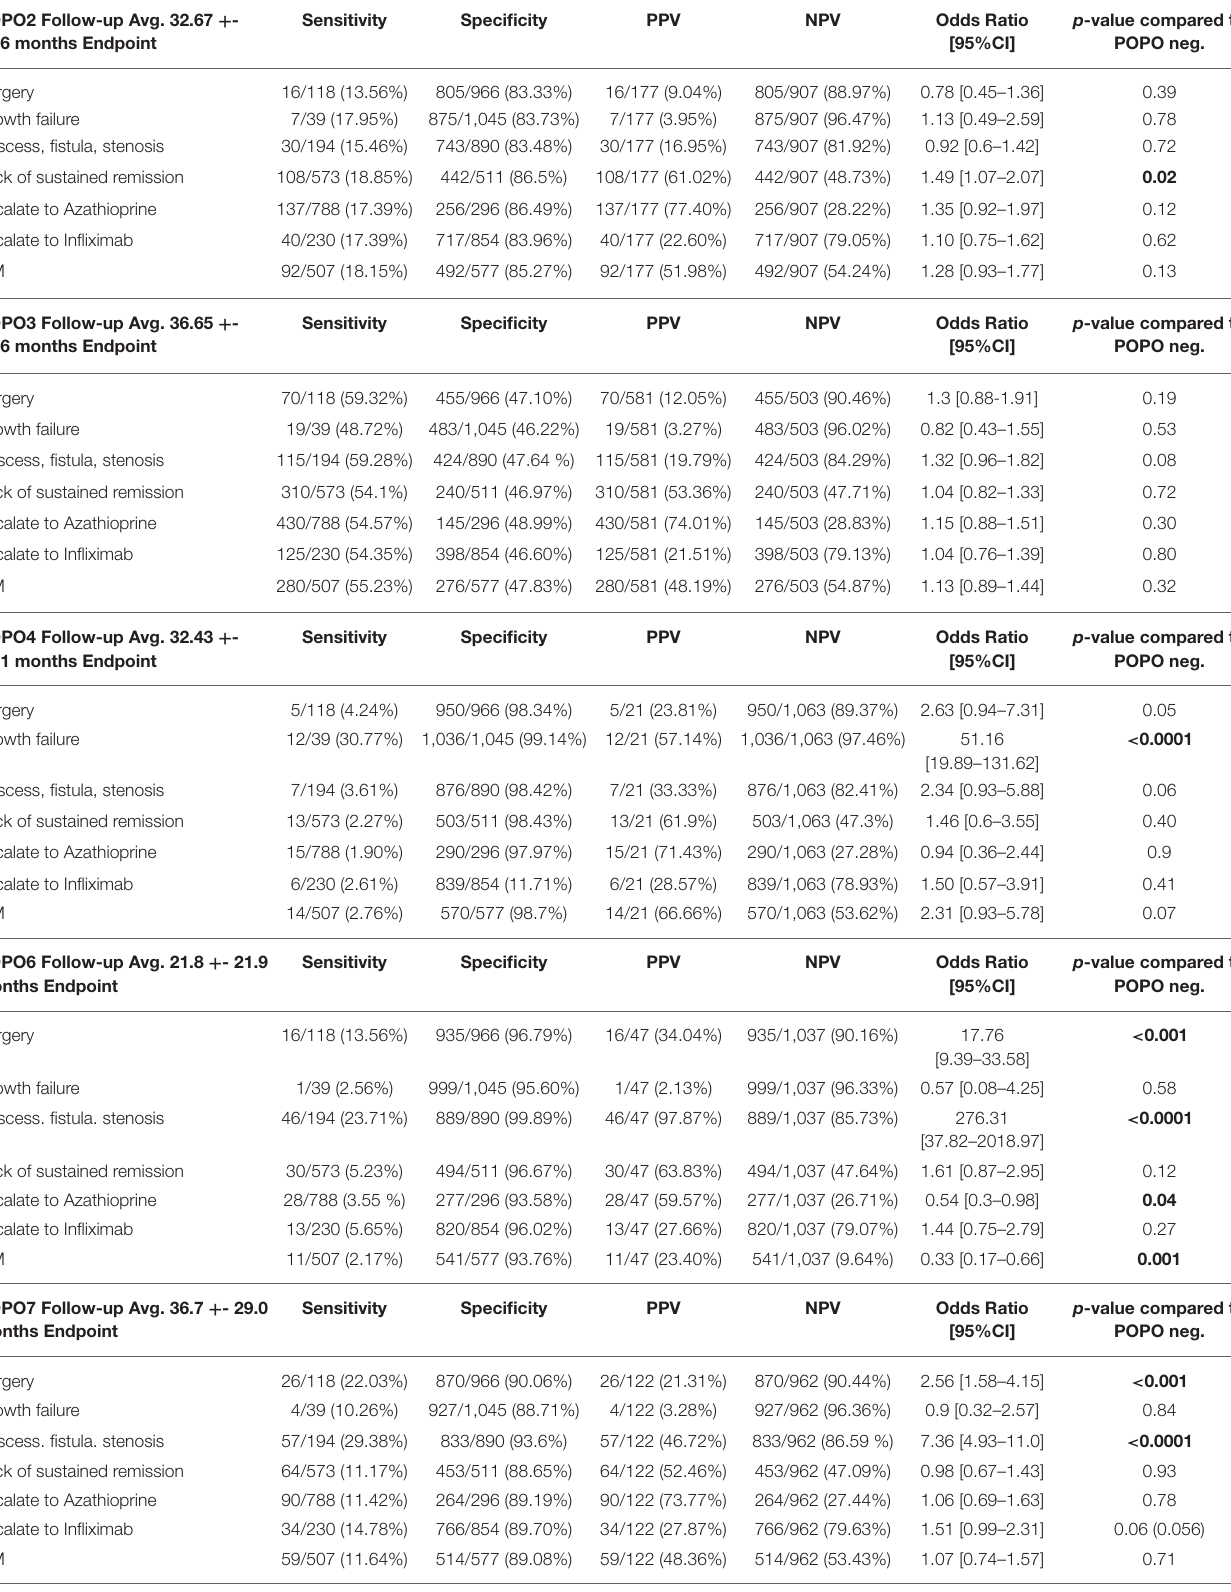
TABLE 3 | POPO-positivity and predictive properties. POPO2 Follow-up Avg. 32.67 + - 26.6 months Endpoint